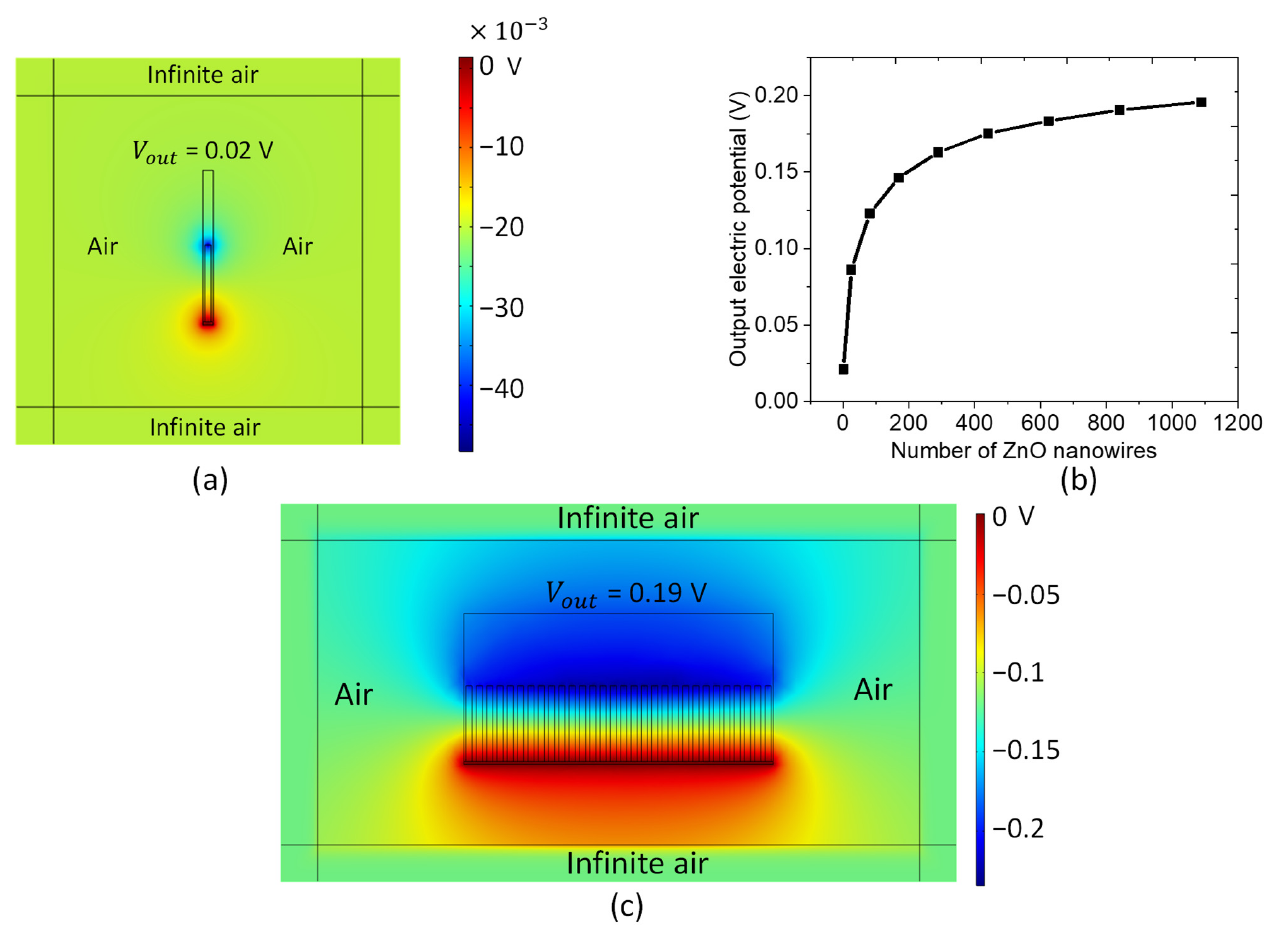
Figure 10. FEM simulation from: ( a ) one nanowire matrix, to ( c ) 30 cells × 30 cells nanowire matrix, subjected to an axial compressive stress of 1 MPa. ( b ) Variation of the electric potential on the top electrode as a function of the number of NWs.